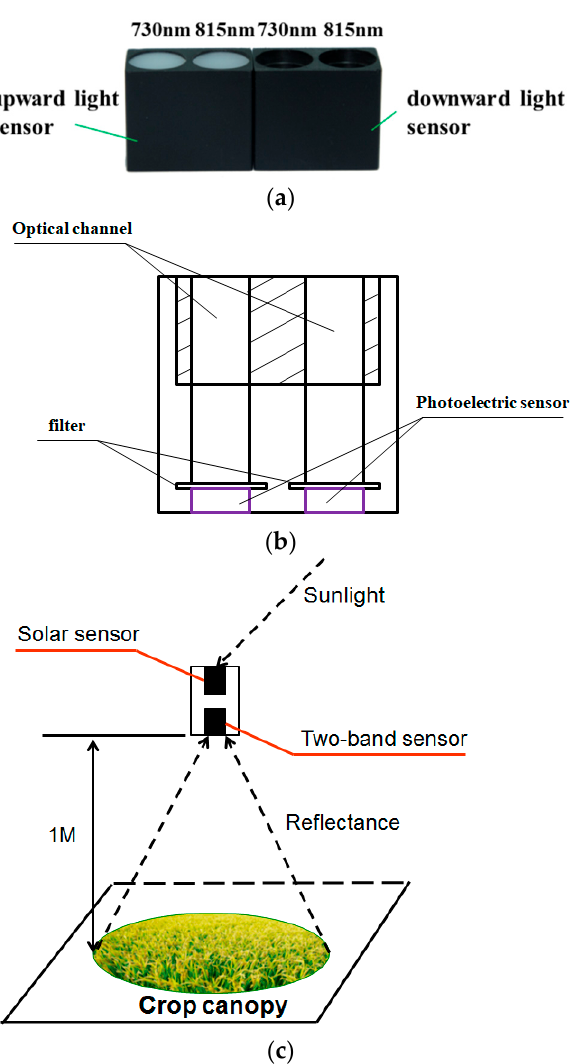
Figure 2. Introduction of dual-band crop-growth sensor. ( a ) Sensor; ( b ) sensor structure; ( c ) schematic diagram of dual-band crop-growth sensor test.